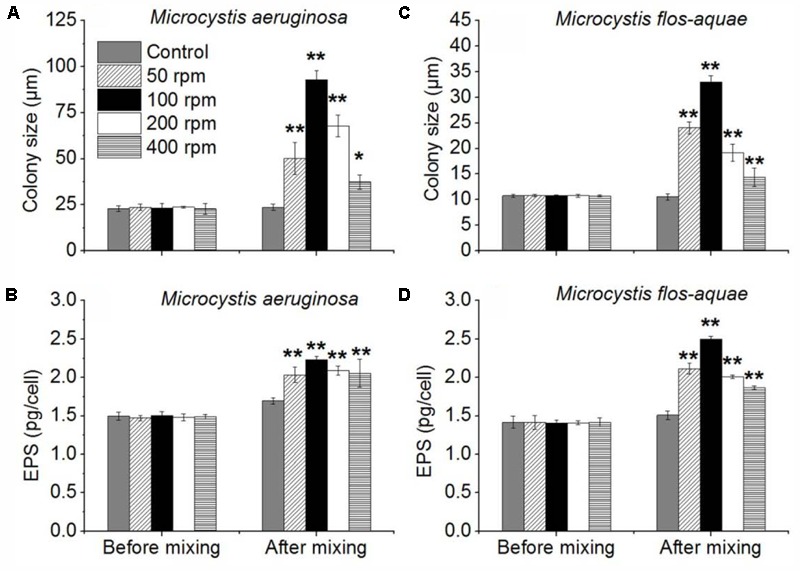
Effects of different mixing intensity (four shaking intensity and control) on colony size and EPS of Microcystis. (A) Mean M. aeruginosa colony size of control and 50, 100, 200, and 400 rpm. (B) Mean M. aeruginosa EPS concentrations of control, 50, 100, 200, and 400 rpm. (C) Mean M. flos-aquae colony size of control and 50, 100, 200, and 400 rpm. (D) Mean M. flos-aquae EPS concentrations of control and 50, 100, 200, and 400 rpm; error bars was indicated by ±SD (∗p < 0.05, ∗∗p < 0.01, n = 3).